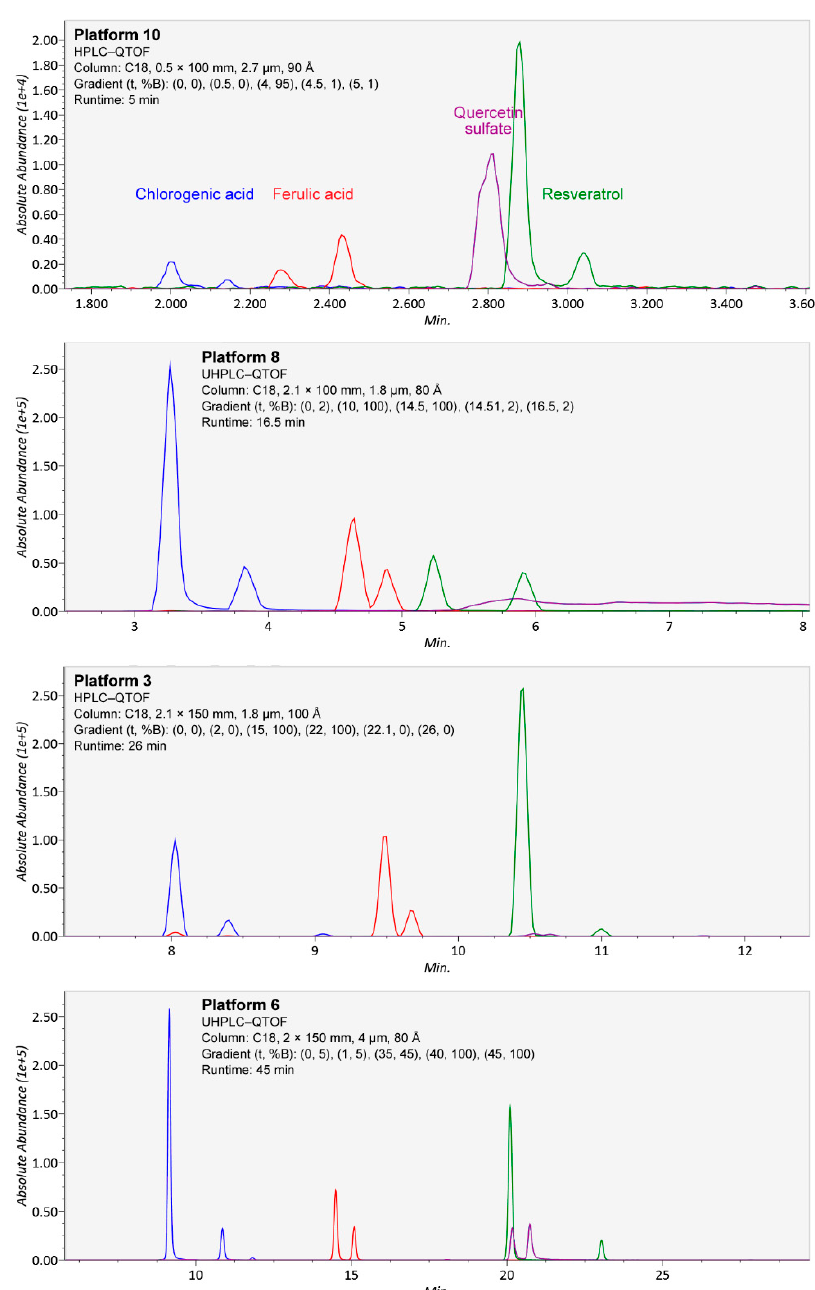
Figure 5. Separation of isomers from chlorogenic acid (blue), ferulic acid (red), resveratrol (green), and quercetin sulfate (purple; quercetin 3- O - and 4- O -sulfate, from separate chemical standards) in four platforms (10, 8, 3, and 6) using different chromatographic conditions, in ascending order of chromatography runtime. In the platforms, both forms of chlorogenic acid (3- O -caffeoylquinic and 5- O -caffeoylquinic acid) and the cis and trans isomers of ferulic acid and resveratrol, contained in single standards as mixtures, were well separated. However, in platforms 8 and 10, the isomers of quercetin sulfate were not separated due to tailing, and in platform 3, the compounds produced well-separated but weak signals.